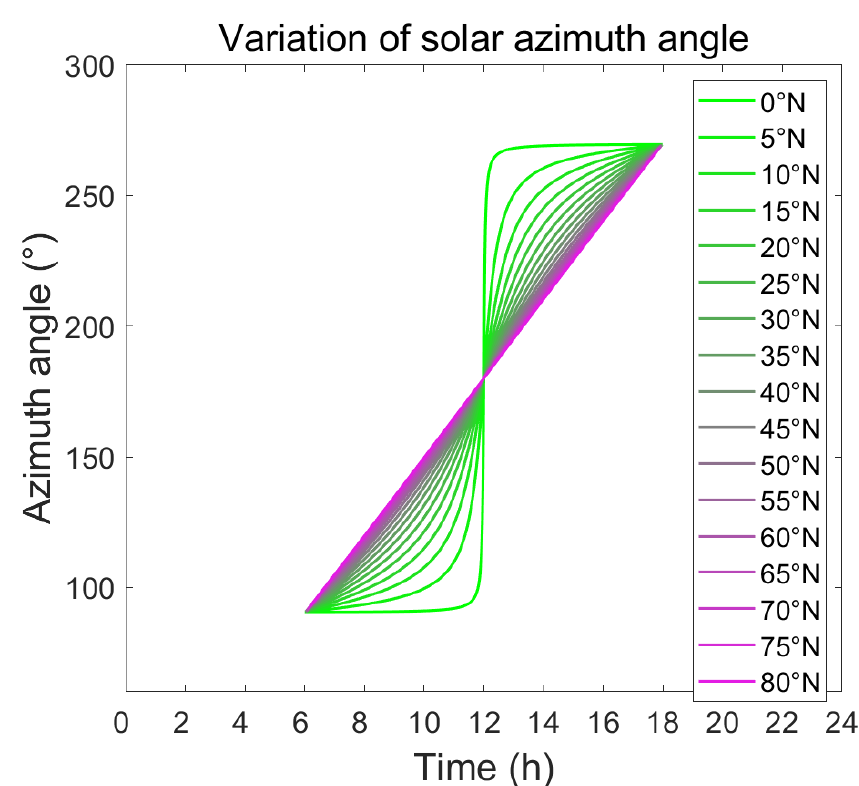
Figure 7 illustrates the daily variation of the solar azimuth with latitude. At high latitudes, the solar azimuth is essentially at a uniform rate. The lower the latitude, the faster the azimuth changes at noon, and the slower it changes at sunrise and sunset. For the point on the equator, since the Sun shines directly on the equator at the equinox, the Sun is always due east (90 ◦ azimuth) before noon, and after noon, it is always in the west (180 ◦ azimuth). Therefore, the curve at 0 ◦ N behaves as a vertical line at 12:00, as shown in Figure 8.